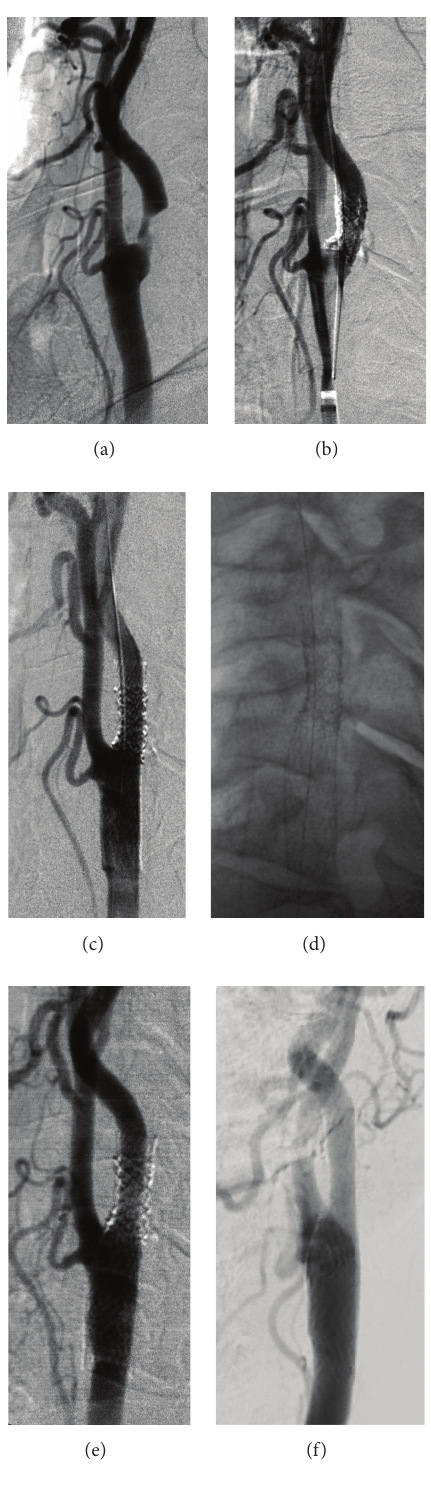
Figure 1: Digital subtraction angiogram shows eccentric, short segment plaque in the internal carotid artery next to the carotid bulb (a). After placing a protection filter (Emboshield NAV6), a covered stent (Direct Stent) was deployed to cover the plaque fully (b). In (c), angiogram shows no residual stenosis following both the insertion of a tapered, closed-cell stent (X-act) covering the covered stent and extending from the common to the internal carotid artery and the dilation of a 5 mm balloon. The stents are clearly visible in (d). Follow-up angiogram performed at the 6th (e) month shows no restenosis but minimal intimal hyperplasia inside the stents. The hyperplasia inside the stents is seen unchanged in the 12th-month angiogram